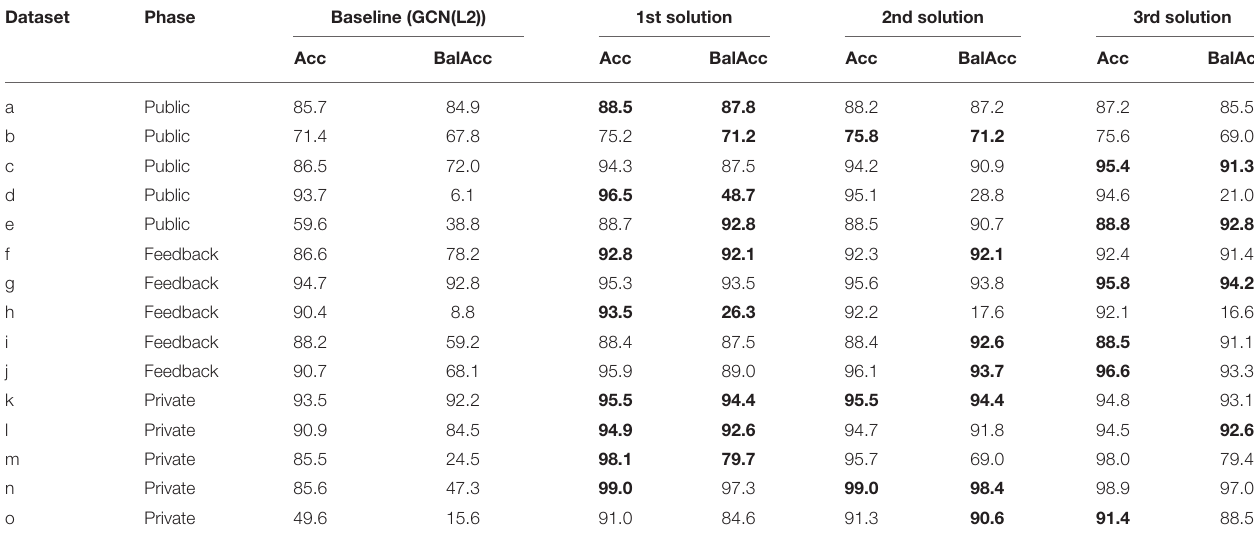
TABLE 3 | Accuracy and Balanced accuracy of top methods on all datasets (%). Dataset